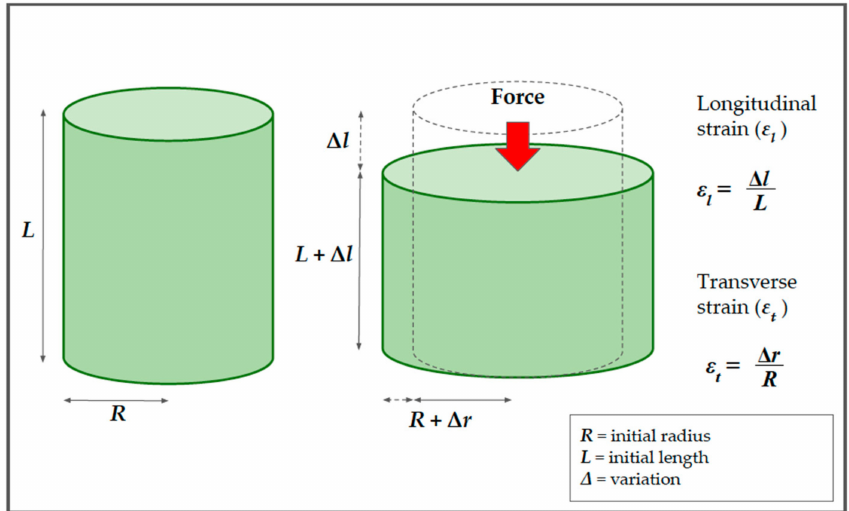
Figure 4. The relationship between the longitudinal and the transverse strains in solids, using a cylindrical model. Before compression, the cylinder has a length ( L ) and radius ( R ). After the application of force (red arrow), the cylinder becomes thinner and wider. The longitudinal strain ( ε l ) is defined as the ratio between the change in length ( ∆ l ) and the initial length ( L ). The transverse strain ( ε t ) is defined as the ratio between the variation of the radius ( ∆ r ) and the initial radius ( R ). For this cylinder, it is possible to calculate not only the longitudinal strain, ε l , but also the transverse strain, ε t . The percentage change in the radial direction, ε t , is called